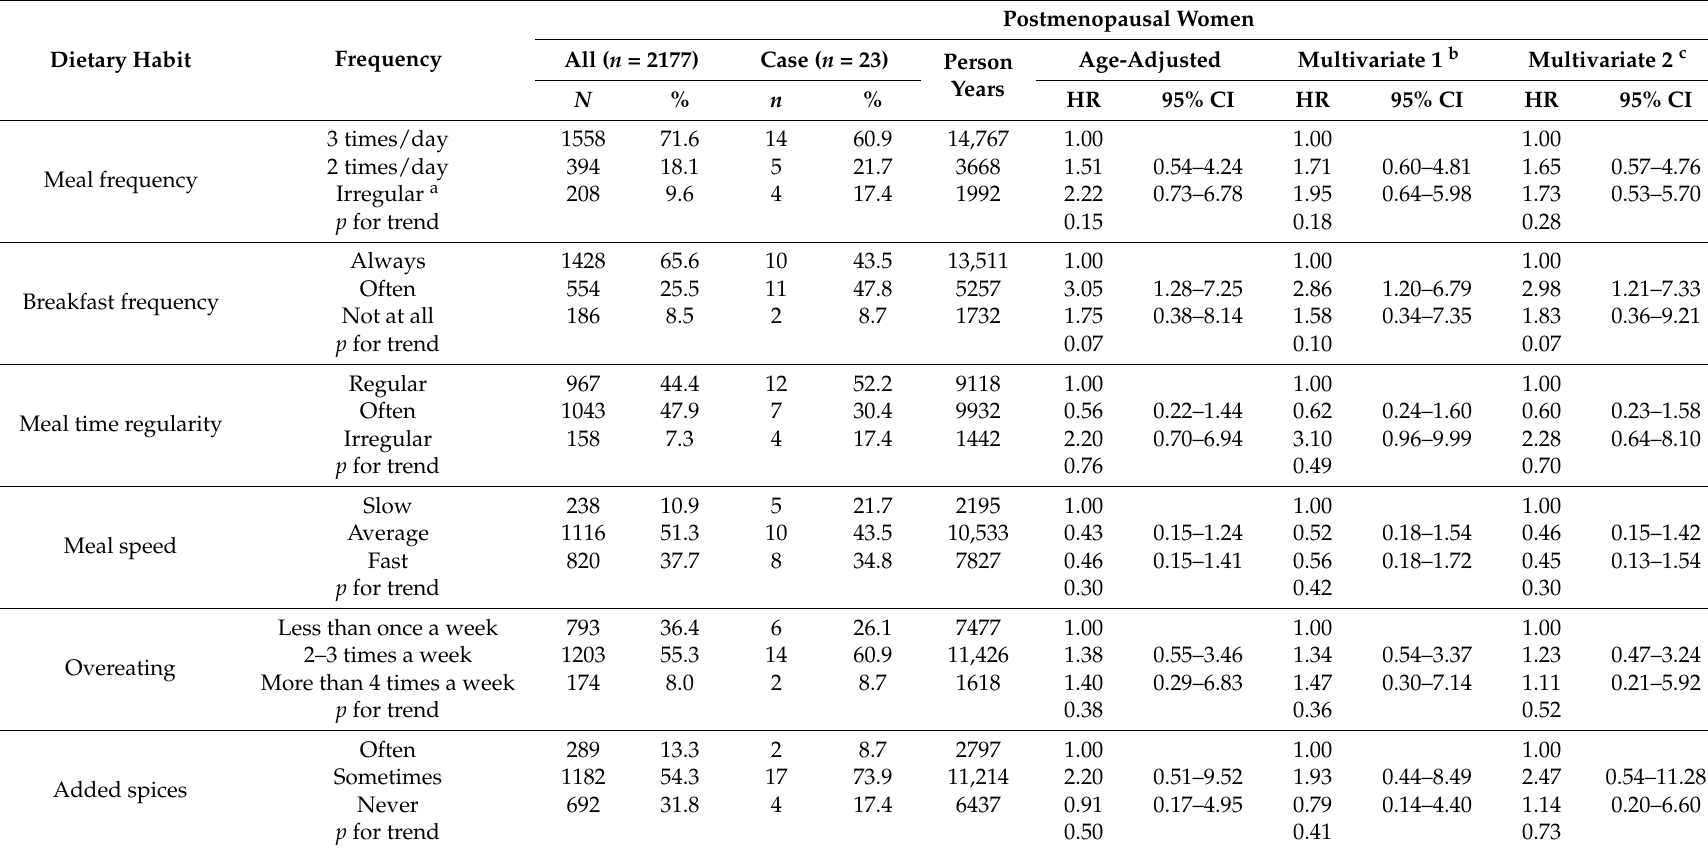
Table 7. Six dietary habits and their associations with breast cancer risk in postmenopausal